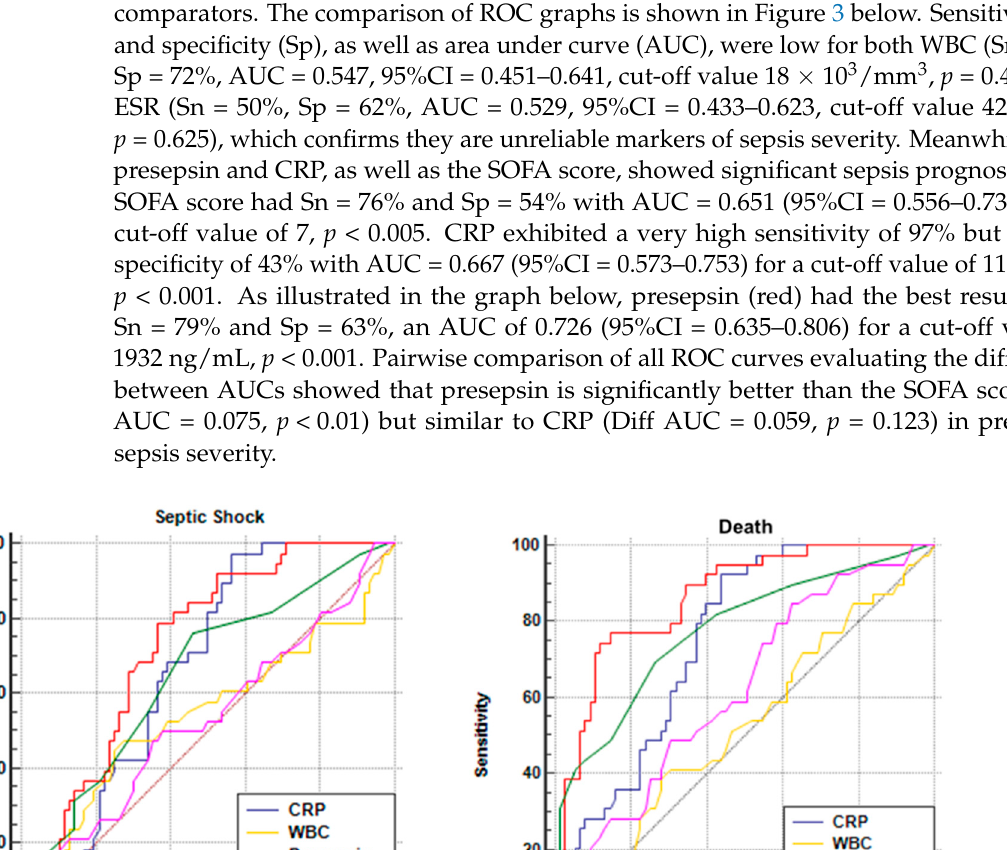
Figure 2. Correlations between presepsin-Sequential Organ Failure Assessment (SOFA) ( A ), C reactive protein (CRP)-SOFA ( B ), and CRP-presepsin ( C ) in patients with sepsis. Correlation equa- tions and R 2 values provided within graphs.